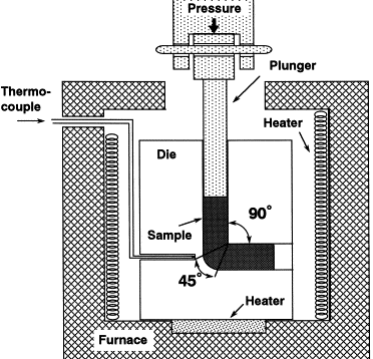
Figure 10. Schematic illustration of the ECAP reprinted from ref. [34]. Copyright 2022 ELSEVIER.